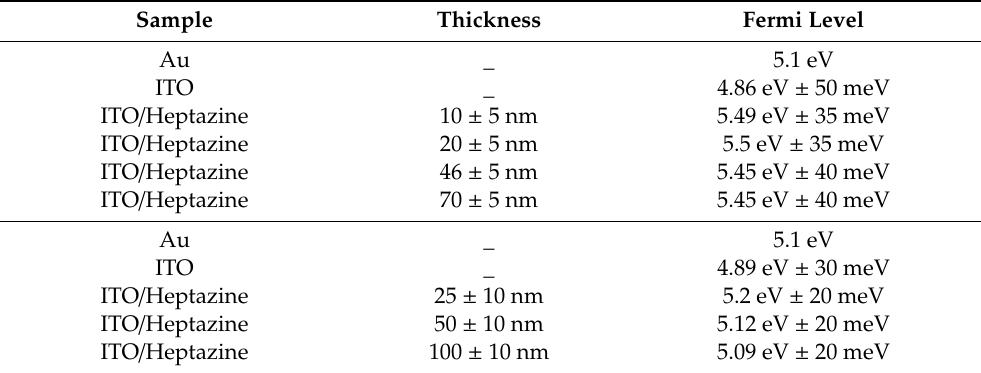
Table 2. Extraction potential values for the di ff erent heptazine layers, including the gold and ITO references. Top, evaporated layers; bottom, spin-coated